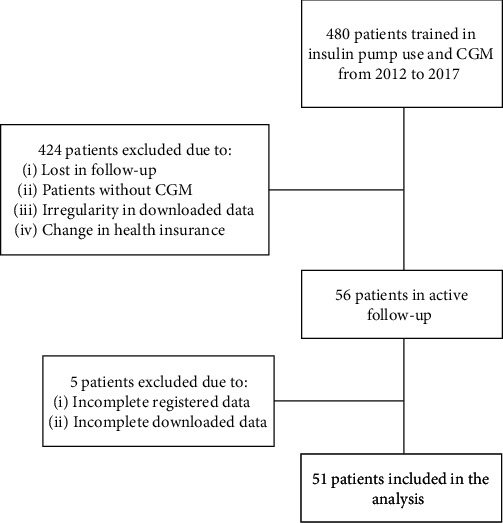
Flow diagram of patients in the study. CGM: continuous glucose monitoring.